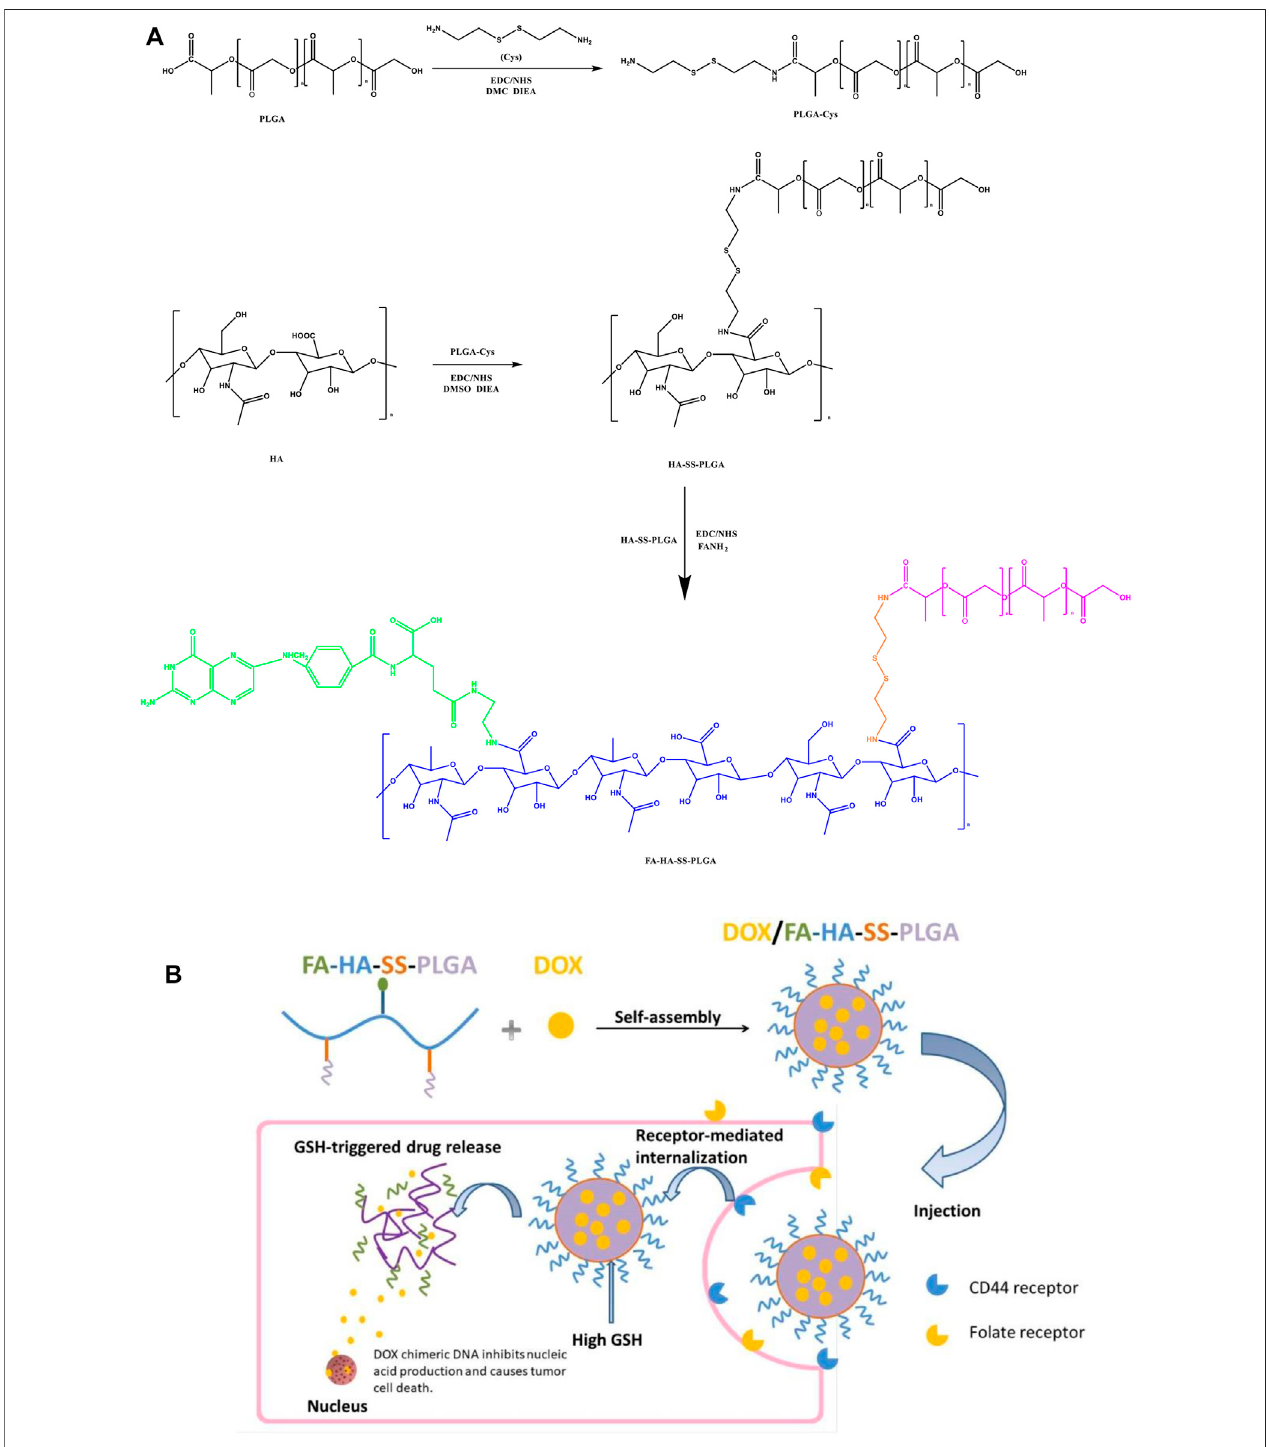
FIGURE 1 | (A) Preparation process of folic acid (FA)-hyaluronic acid (HA)-SS-poly (lactic-co-glycolic acid) (PLGA). (B) Illustration self-assembly, tumor aggregation, and intracellular release of doxorubicin hydrochloride (DOX)/FA-HA-SS-PLGA micelles.